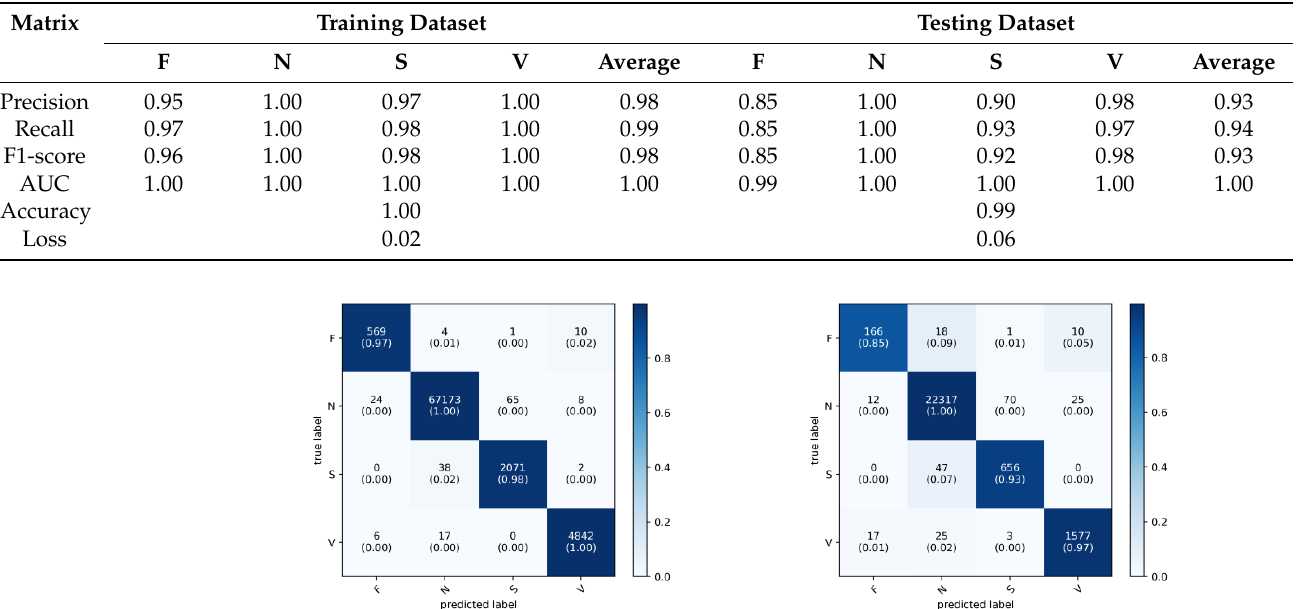
Table 3. Confusion matrix report of 1D-CNN model.